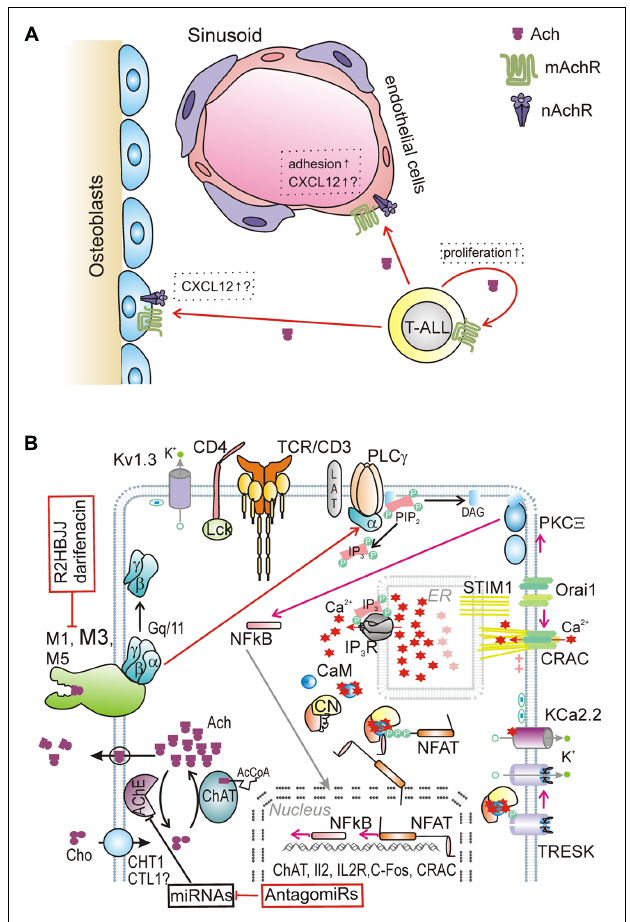
FIGURE 2 | Hypothetical model of NNCS involvement in T leukemogenesis. (A) Autocrine and paracrine effect of ACh derived from T leukemic cell in specific leukemic niche in BM. (B) Network of signaling events in leukemic T lymphoblasts. It is suggested, that in absence of TCR/CD3 stimulation in leukemic T cells, elevated level of ACh production and autostimulation through M (1, 3, 5) receptors may play key role in signaling network. The sustained CRAC-mediated Ca 2 + influx is maintained due to K + efflux via a set of K + -selective channels: voltage-dependent K v 1.3 and